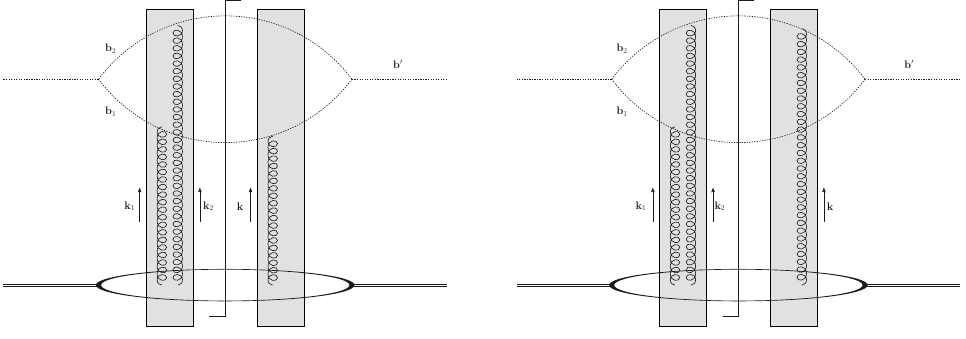
Figure 3 . 3-body contributions with 2 gluons in the